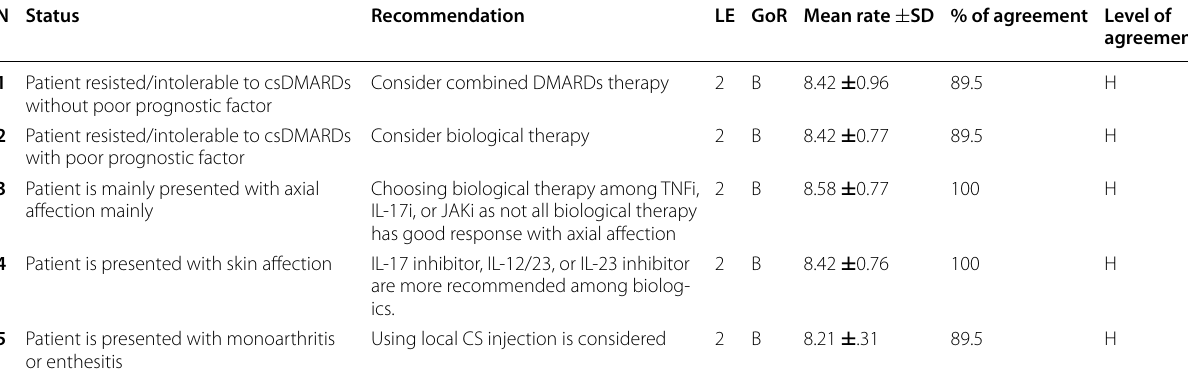
Table 6 Personalized management. A suggested management approach to psoriatic patients tailored to their clinical manifestations and prognostic markers